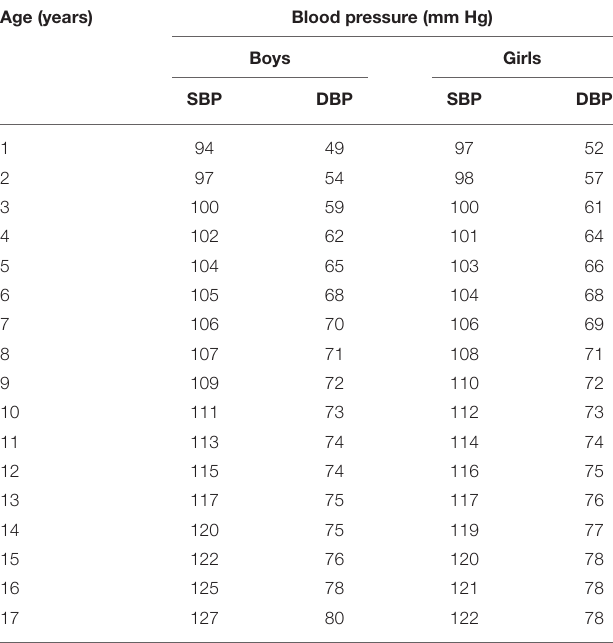
TABLE 1 | Simplified blood pressure table for the screening of potential arterial hypertension. Age